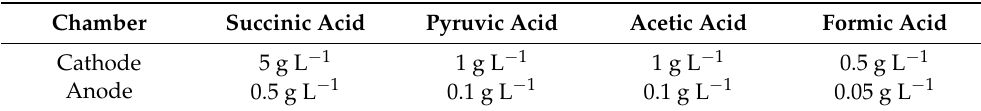
Table 3. Composition of mixed acids solutions at the onset of the experiments in the anode and cathode chambers.